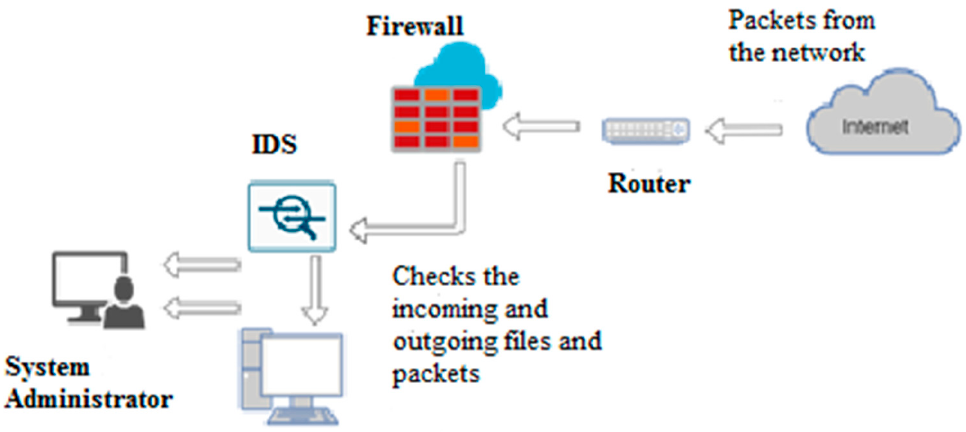
Figure 1. Analytical Model for Network Intrusion Detection System with Deep learning.